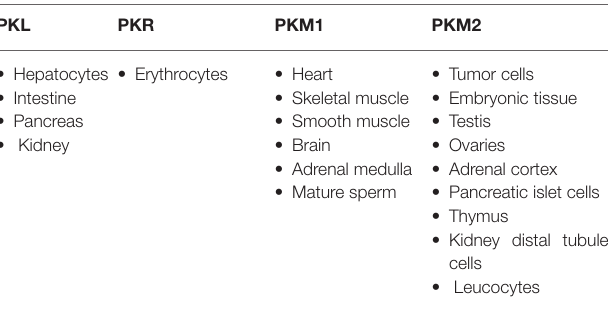
TABLE 1 | Tissue-specific isoforms of pyruvate